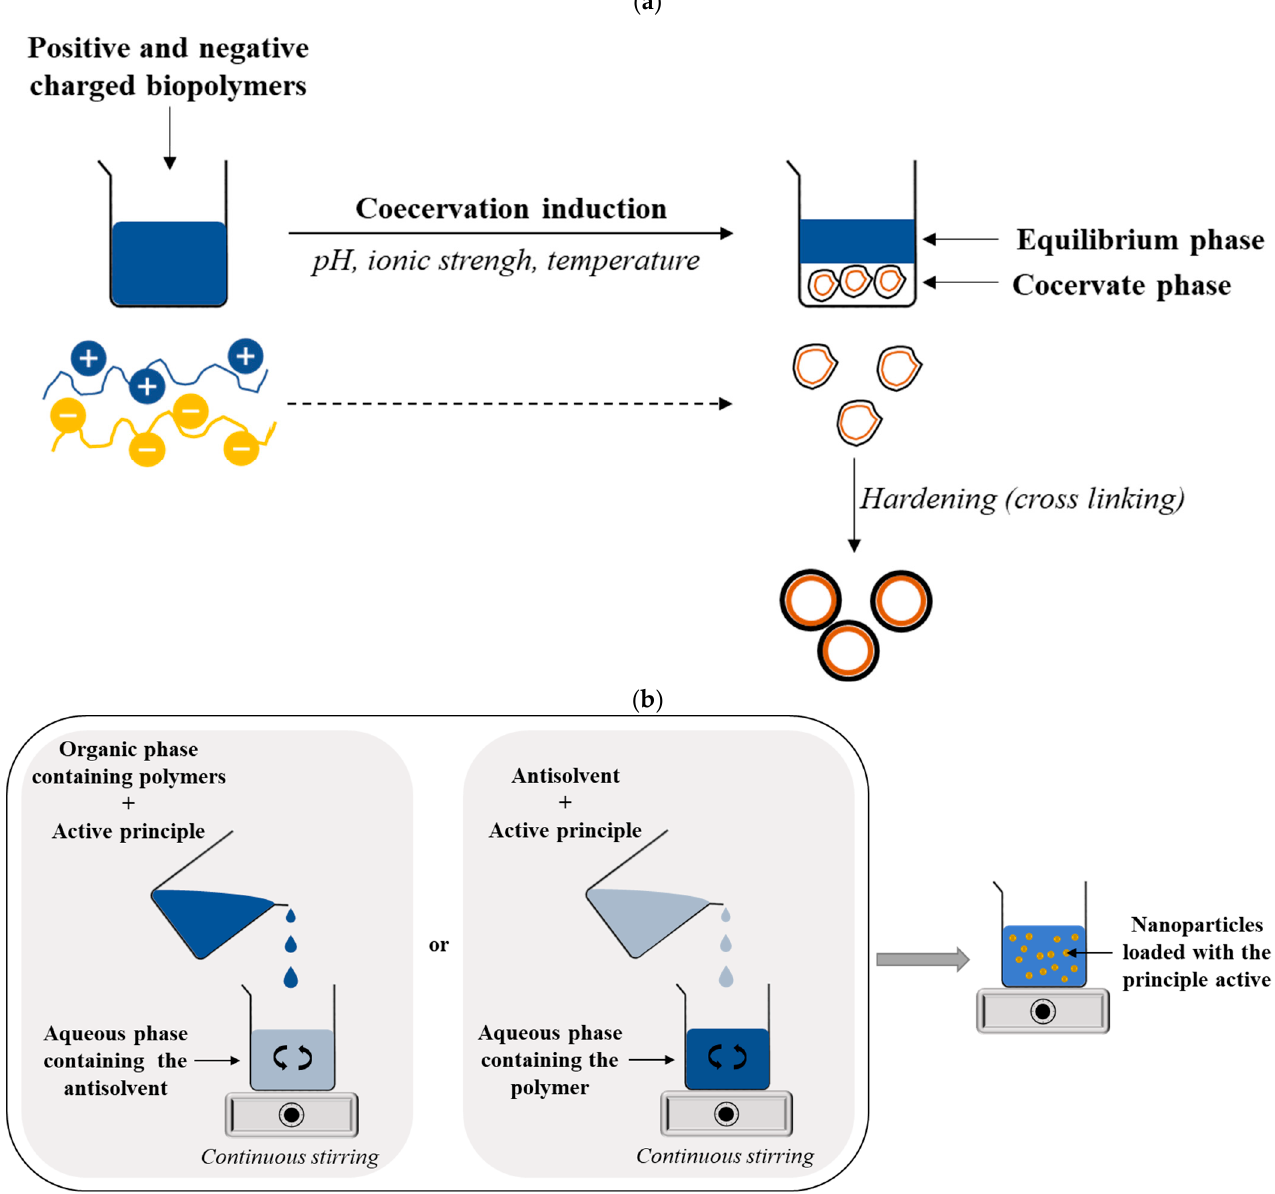
Figure 3. Principle of encapsulation by ( a ) complex coacervation and ( b ) nanoprecipitation.